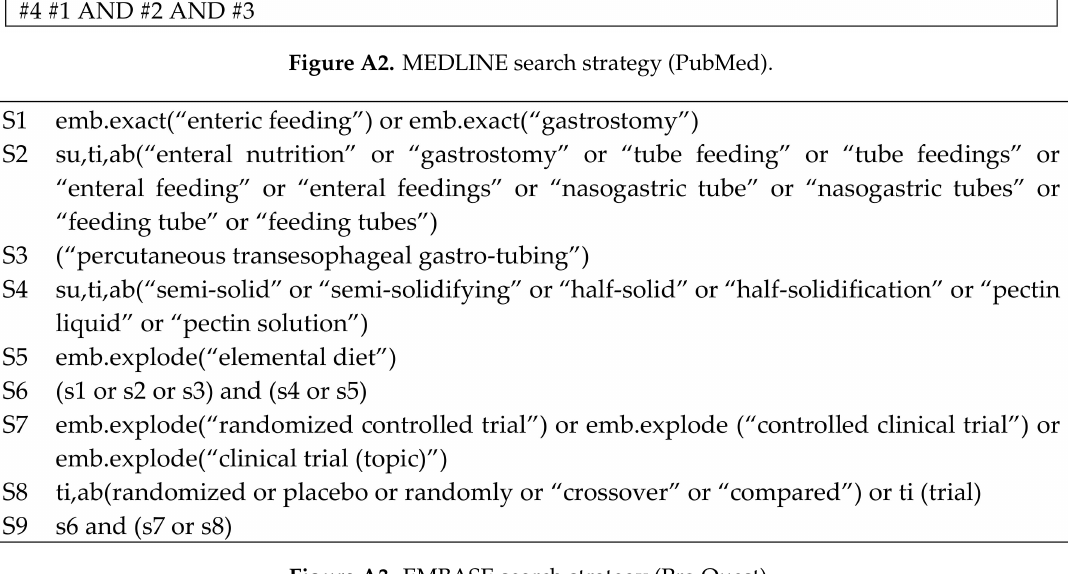
Figure A3. EMBASE search strategy (Pro Quest).